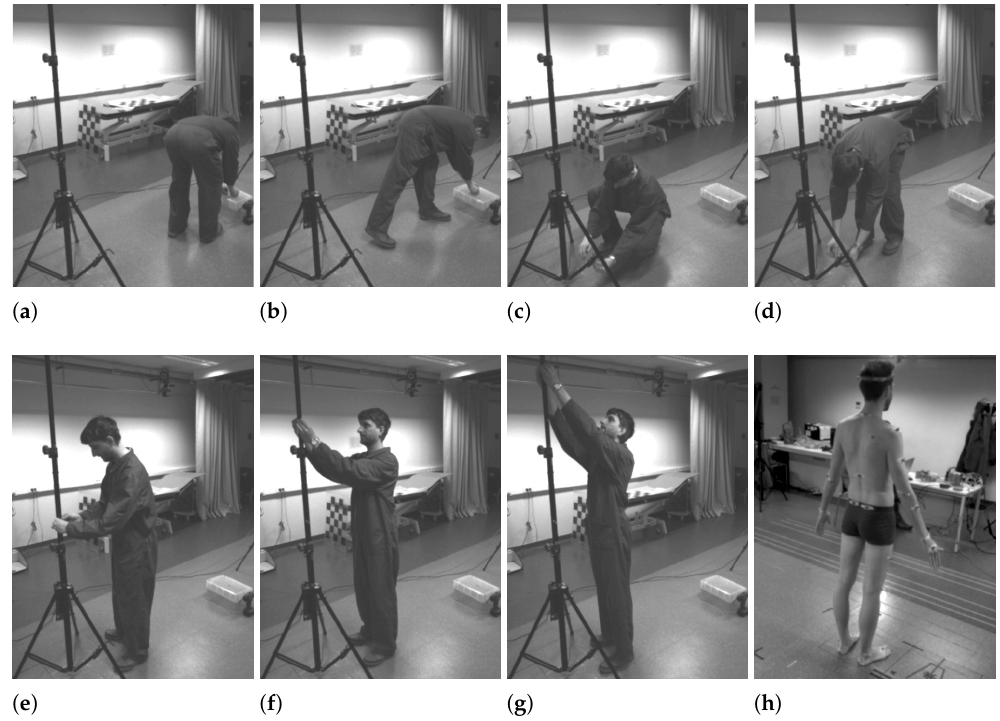
Figure 6. Different actions and poses of the subjects. Some actions can be performed in different poses. ( a , b ) Pick up a nut and bolt. ( c , d ) Fasten nut and bolt at 0.25m, ( e ) at 1.15m, ( f ) at 1.75m, ( g ) at 2.1m. ( h ) Subject with VICON